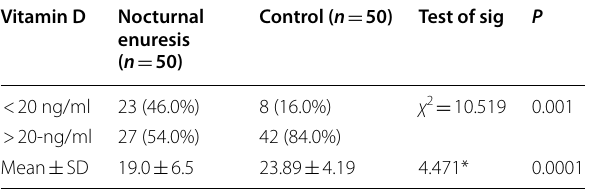
Table 2 Comparison between the two studied groups